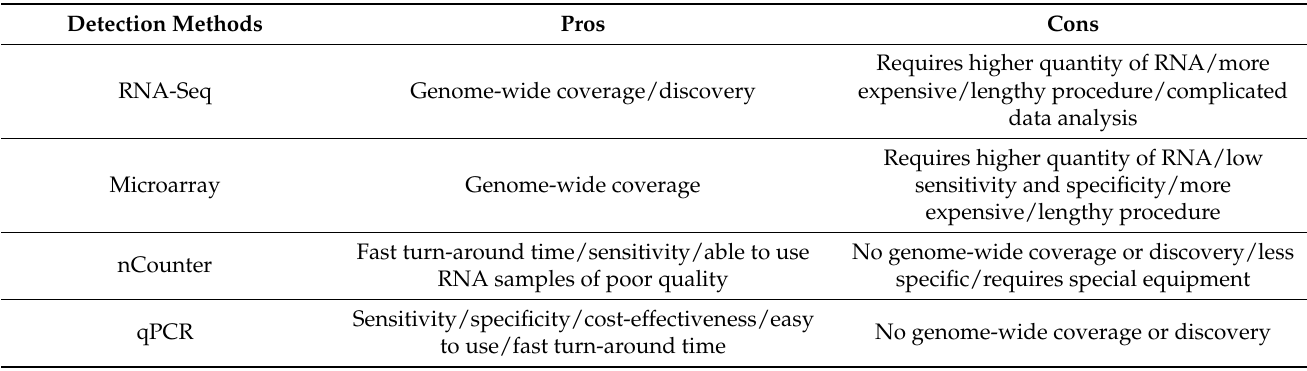
Table 3. Pros and cons of commonly used biofluid miRNA detection